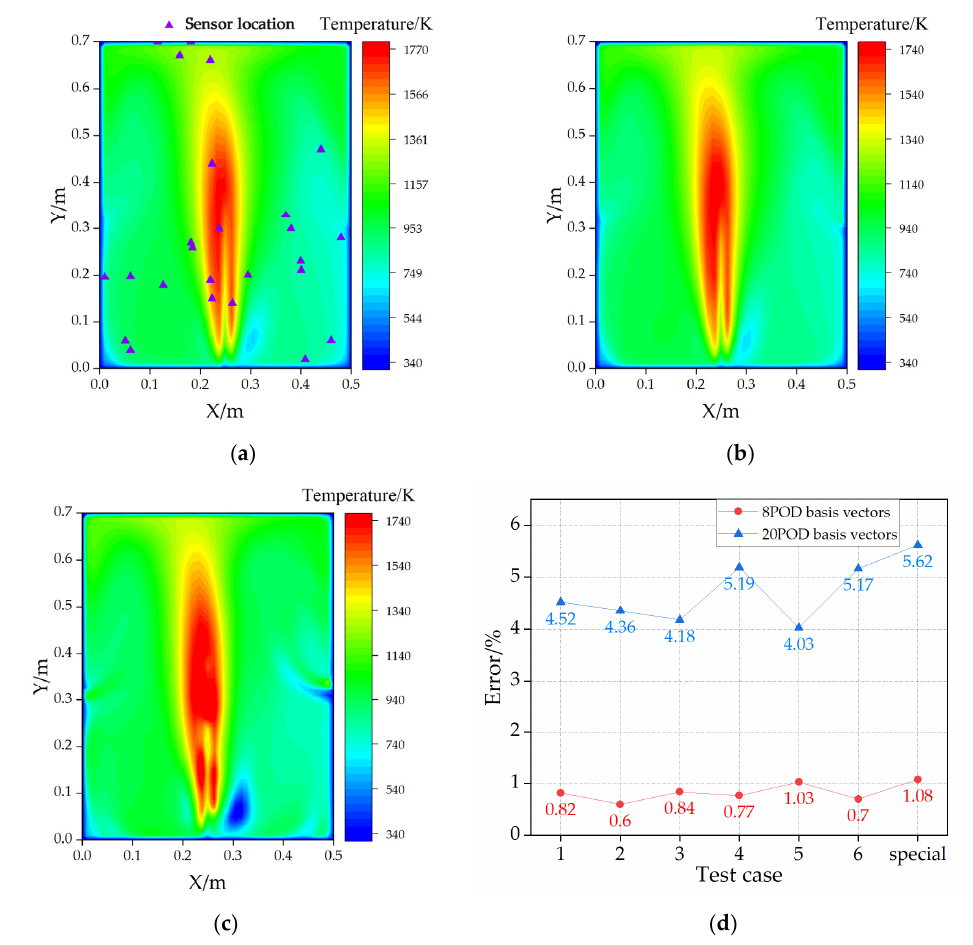
Figure 2. Comparisons of the reconstruction results. ( a ) Simulation results in the special test case, ( b ) reconstruction results in the special test case (eight proper orthogonal decomposition (POD) basis vectors), ( c ) reconstruction result in special test case (20 POD basis vectors), and ( d ) reconstruction errors in different test cases.